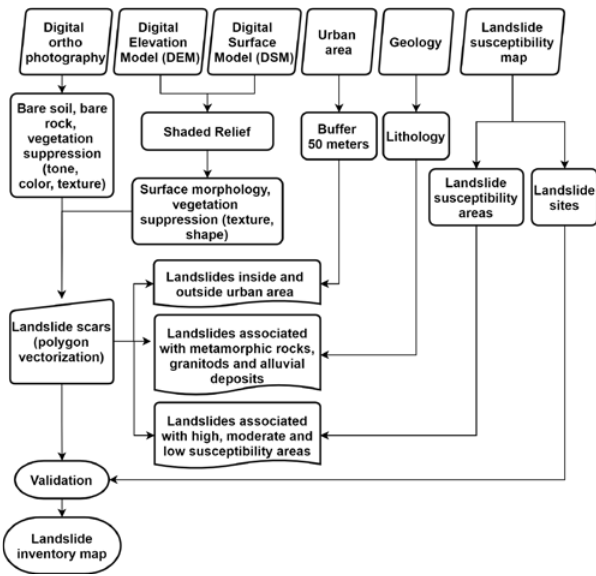
Figure 2. Flow chart shows the